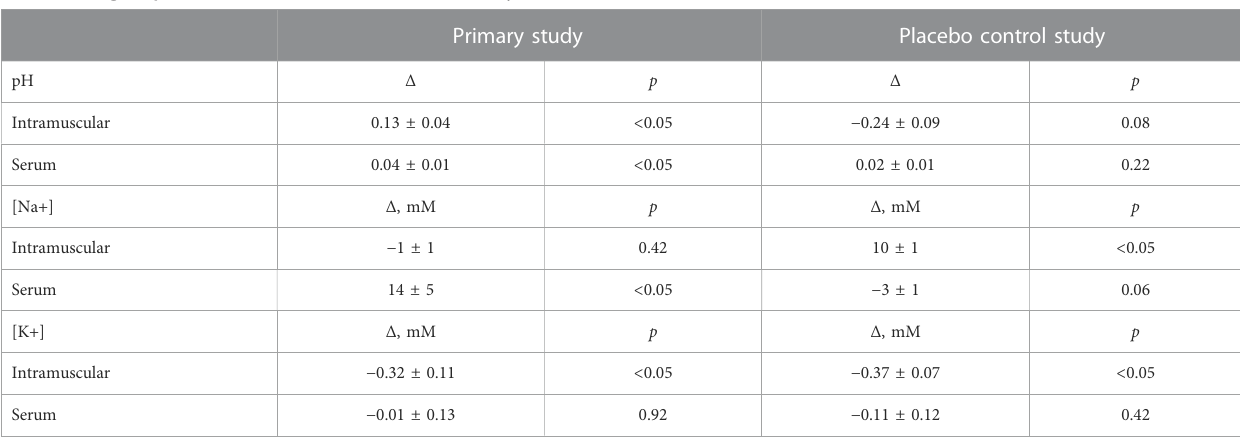
TABLE 2 Change in pH, Na+, and K+ from baseline to end-of-study . Primary study Placebo control